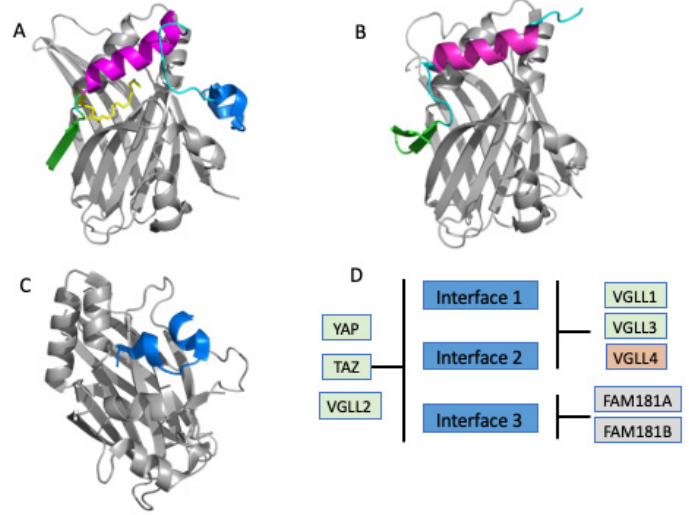
Figure 2. Ribbon diagram of the core structures of the complexes of TEAD-coregulators. ( A ) The YAP-TEAD complex (PDB: 3KYS); ( B ) the mVGLL1-TEAD complex (PDB: 5Z2Q); ( C ) the FAM181A-TEAD complex (PDB: 6SEN). The TEAD structure is displayed in grey, the interface 1, β sheet, in green; interface 2, α helix, in magenta; interface 3, the Ω loop, in blue; the loops in cyan; ( D ) Coregulators bind on different interfaces (light blue). Coactivator proteins are shown in light green, corepressor in orange, and proteins with unknown function in gray.